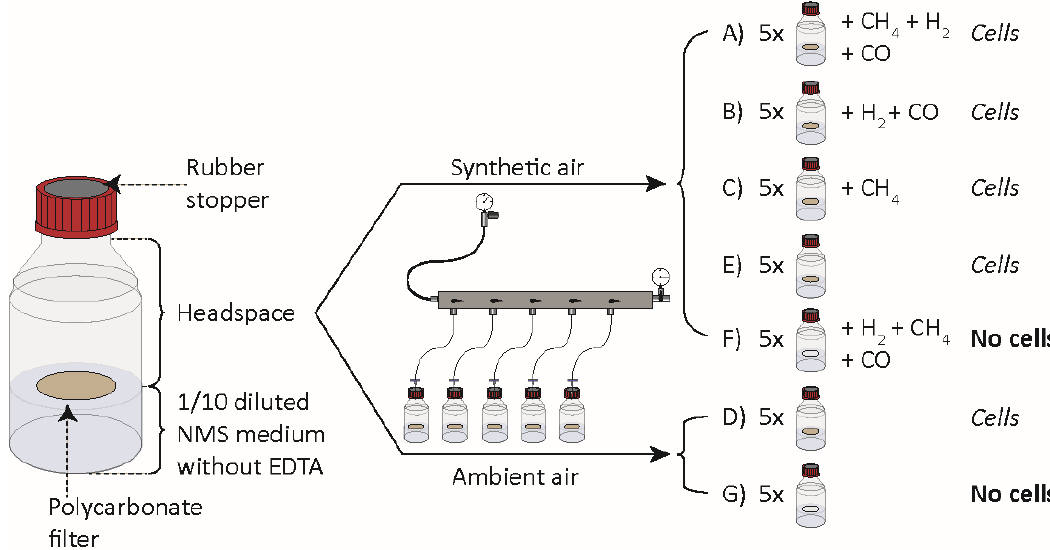
Figure 2. Experimental setup for experiment 1 to determine gas uptake by M. gorgona MG08. NMS: Nitrate mineral salts. Synthetic air containing less than 0.2 p.p.m.v. of CH 4 , CO and H 2 . Ambient air containing 1.84 p.p.m.v. CH 4 , 0.4 p.p.m.v. CO and 0.7 p.p.m.v. H 2 . All injections of CH 4 , CO and H 2 resulted in a final concentration between 2 and 4 p.p.m.v of the respective gas.